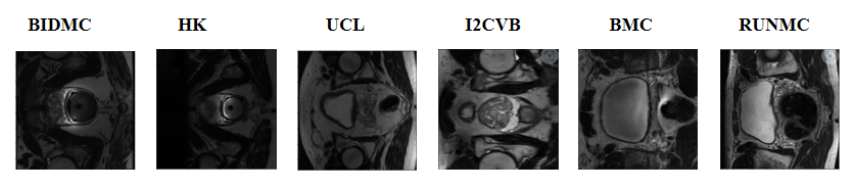
Figure 5. Examples of prostate MRI images from six clients showing considerable statistical